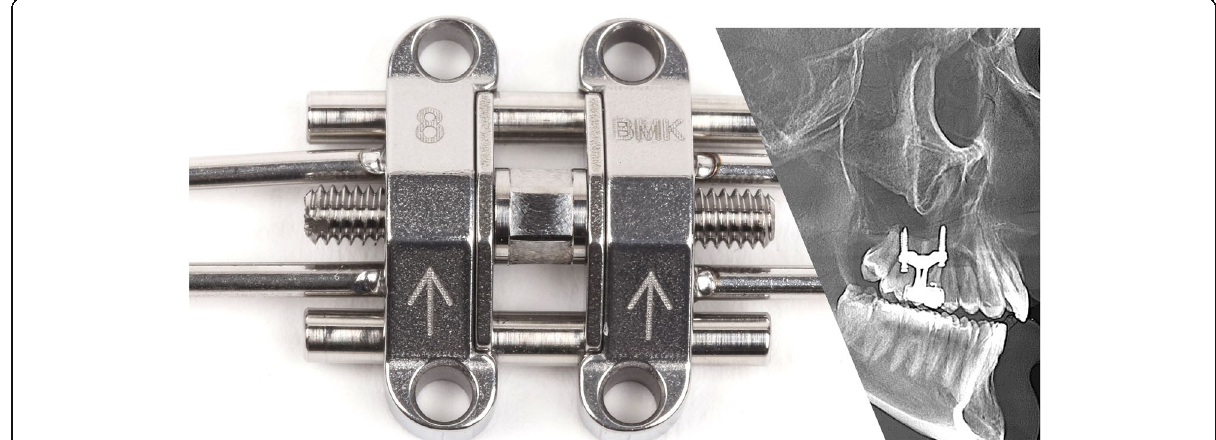
Fig. 3 Midfacial skeletal expander device and X-ray showing bicortical engagement of the four